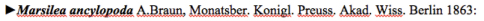
Example of a scientific name entry.